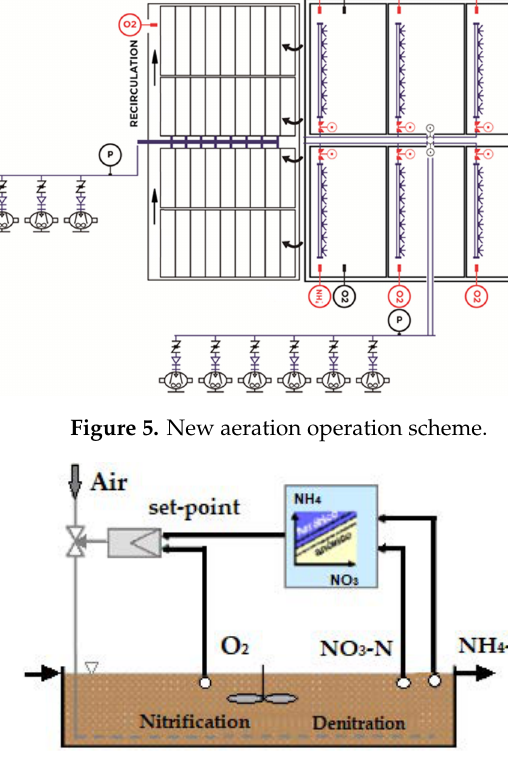
Figure 6. New aeration operation